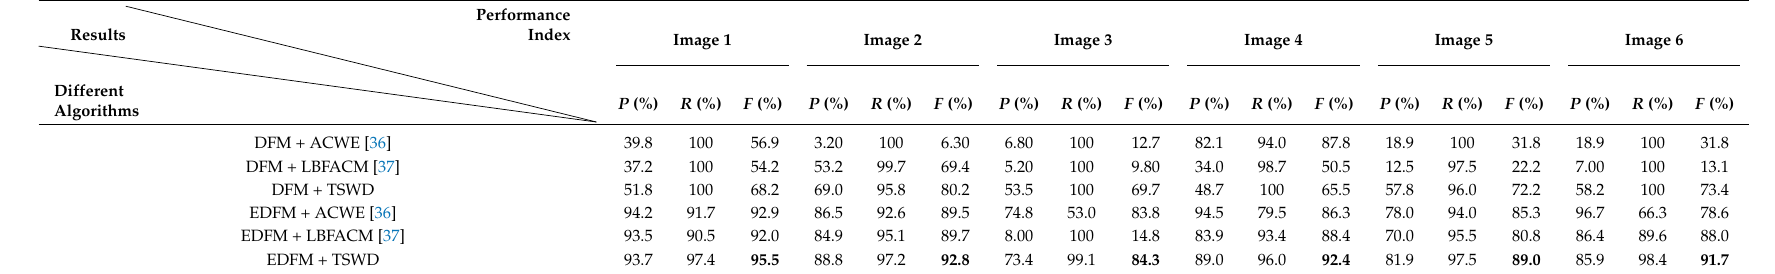
Table 3. Comparative results of different methods.